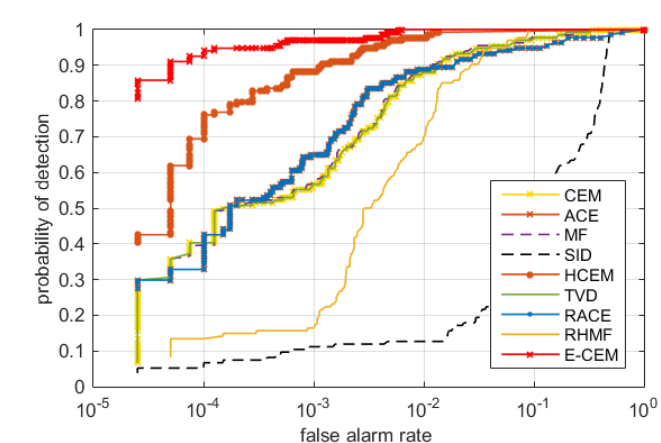
Figure 9. ROC curves of different detection algorithms on AVIRIS San Diego hyperspectral data: CEM [2], ACE [10], MF [11], SID [9], HCEM [17], TVD [15], RACE [37], RHMF [16] and the propose